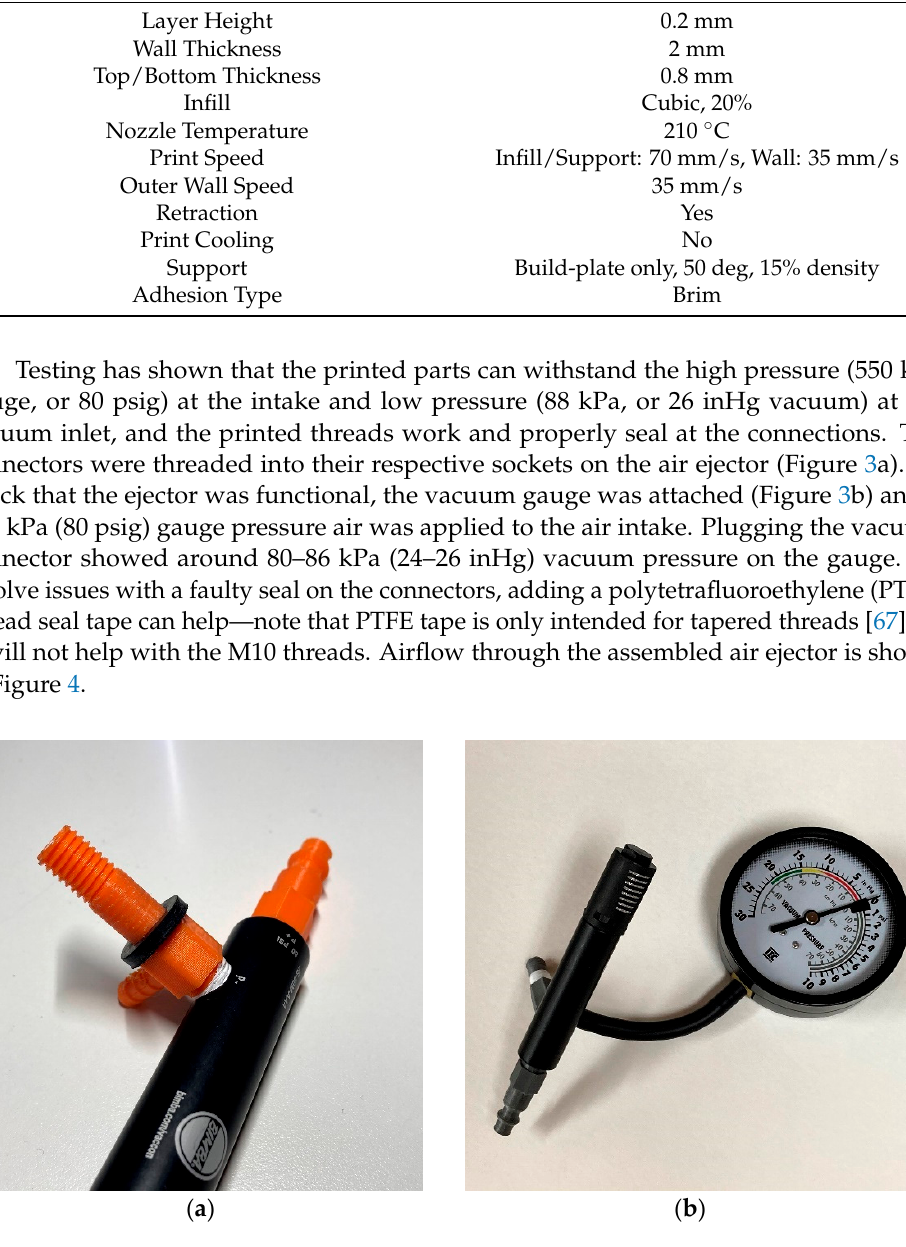
Figure 4. The air ejector is driven by compressed air, which creates a vacuum pressure inside the ejector, pulling air through the vacuum connector into the stream of compressed air. The exhaust is delivered into the atmosphere through a diffuser that reduces airflow noise. With the air ejector assembled and checked, the vacuum inlet was fed through the two circles of insulation. Next, one M10 washer was placed on the inlet (Figure 5a), then the inlet was fed through the lid of the vacuum chamber. The other M10 washer was ap- plied and the M10 nut was tightened onto the threads, securing the air ejector and insula- tion to the lid (Figure 5b).